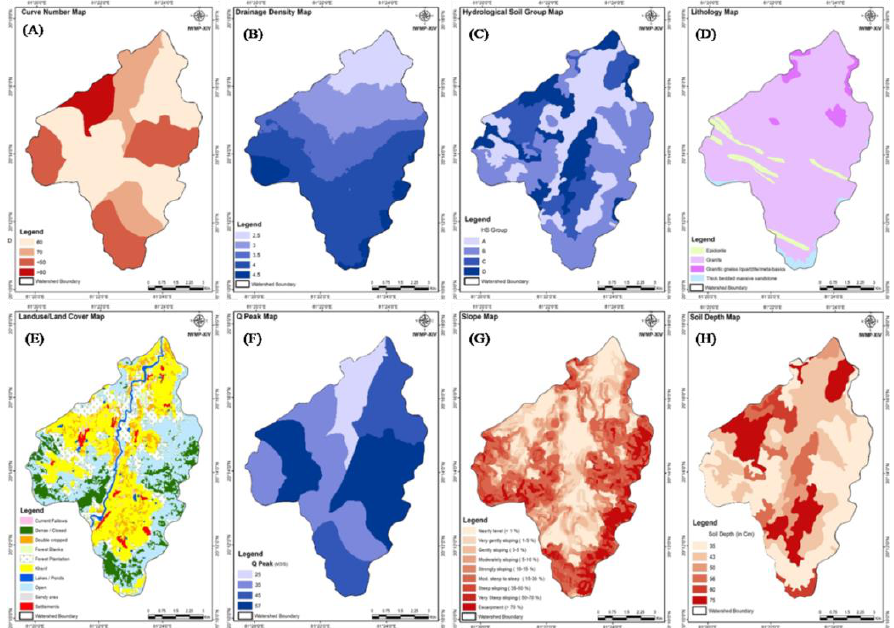
Figure 2: Maps of all thematic